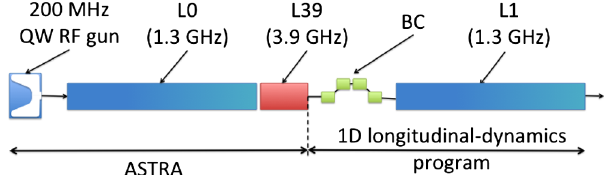
FIG. 8. Block diagram of the accelerator configuration explored for the formation of high-energy ramped bunches. The legend is as follows: “ QW ” stands for quarter-wave, “ L0 ” and “ L1 ” are standard 1.3-GHz cryomodule equipped with 8 TESLA-type SCRF cavities, “ L39 ” is a cryomodule consisting of four 3.9-GHz cavities, and “ BC ” is a magnetic bunch compressor.